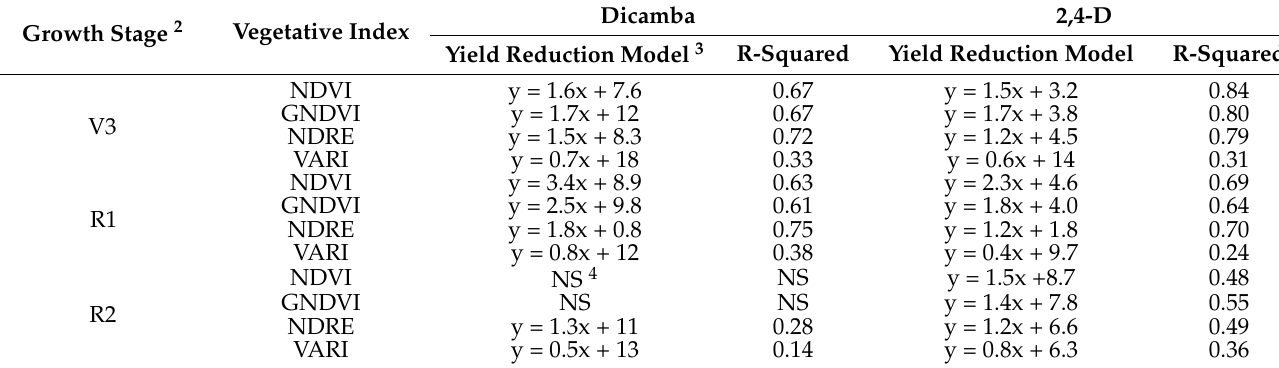
Table 2. Evaluation of relationships between yield reduction and VI value reduction 14 DAT 1